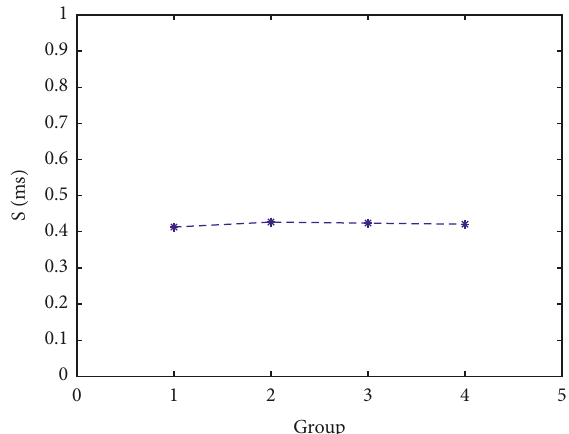
Figure 7: Distribution of the random delay sample standard de- viation (S).